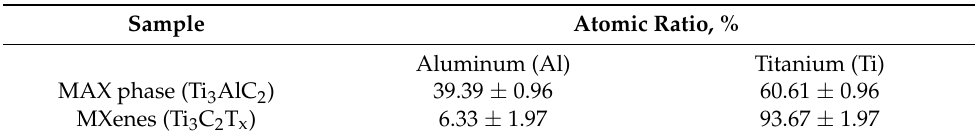
Figure 1. SEM images of ( A ) MAX phase (Ti 3 AlC 2 ) and ( B ) MXenes (Ti 3 C 2 T x ). Table 1. EDX analysis results for aluminum (Al) and titanium (Ti) atomic ratio in MAX phase and MXene samples.